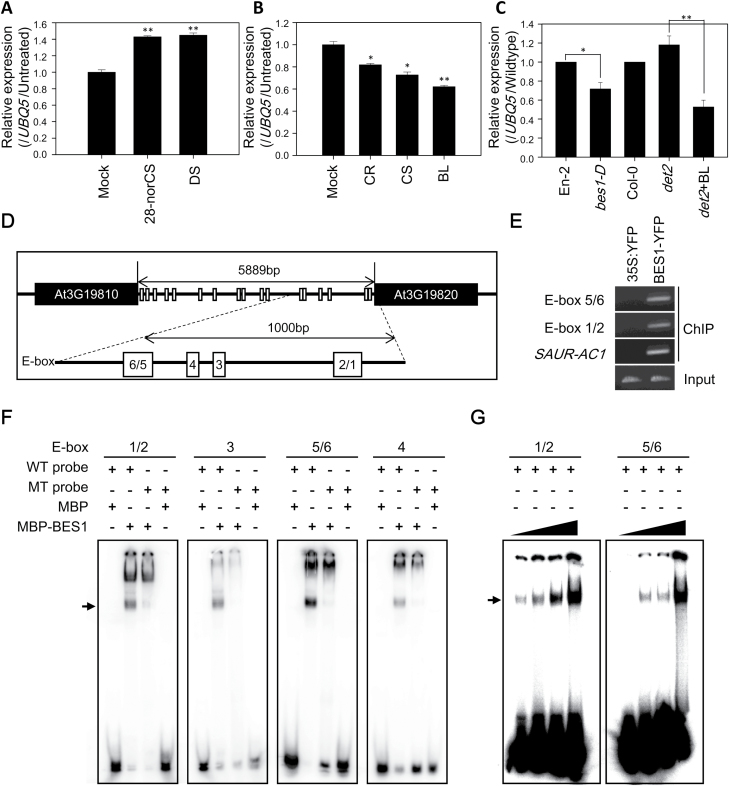
Feedback regulation of DWF1 by BR signaling via BES1 in Arabidopsis. (A) Comparison of DWF1 expression by application of 28-norCS and DS. (B) Comparison of DWF1 expression by application of CR, CS, and BL. Seedlings grown in 0.5× MS medium for 7 d were transferred to DW containing 0.1 µM BRs and incubated for 2 h. (C) Expression of DWF1 in BR-deficient (det2) and dominant (bes1-D) mutants. Data are presented as a relative value (mean ±SE) relative to Mock control (A, B) and wild-type (C). Asterisks indicate the statistical significance by Student’s t-test. *P<0.05, **P<0.01 compared with mock or wild-type. (D) Schematic diagram of DWF1 promoter region. White rectangles indicate E-boxes (CANNTG) on the intergenic region. The six E-boxes were denoted as E-box 1 to E-box 6. E-box 1/2 and 5/6 contain two overlapped E-boxes. (E) ChIP assay results for binding of BES1 to DWF1 promoter in vivo (lanes 1 and 2; Input, lanes 3–8; ChIP with anti-YFP antibody prepared from 10-day-old light-grown 35S:YFP (negative control) and BES1-YFP transgenic seedlings). ChIP-PCR was performed with primers from indicated E-box positions at the DWF1 promoter and SAUR-AC1 (positive control). Each assay was repeated three times. (F, G) EMSA results for binding of BES1 to DWF1 promoter in vitro (F). 32P-labeled DWF1 probes were incubated with or without MBP-tagged BES1 protein. The absence or presence of MBP-tagged BES1 protein is indicated by – or +. MBP proteins and mutated probes (MT probes) were used as a negative control (G). 32P-labeled DWF1 probes were incubated at an increasing concentration (0.5, 1, 1.5, and 2 µg) of MBP-tagged BES1 protein.